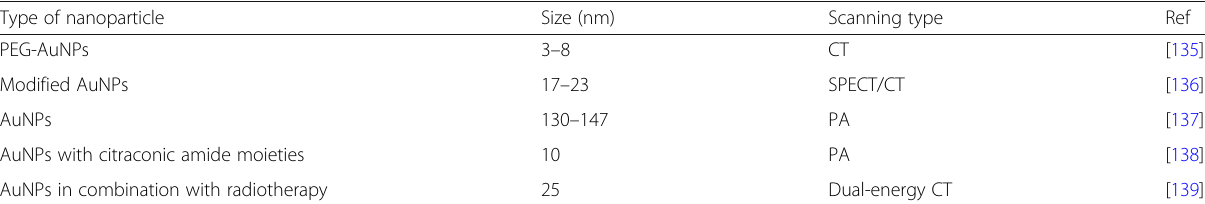
Table 3 Some examples of metal nanoparticles and metal nanoparticle-conjugates that have been investigated for their use in medical imaging